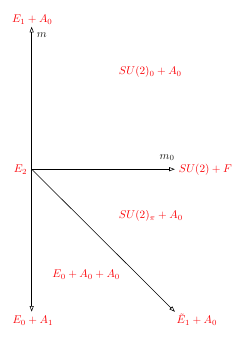
Figure 1 . Phases of the E 2 theory [2].